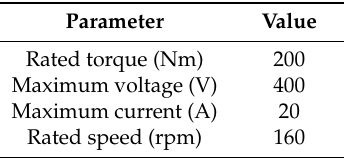
Table 3. Design specifications.